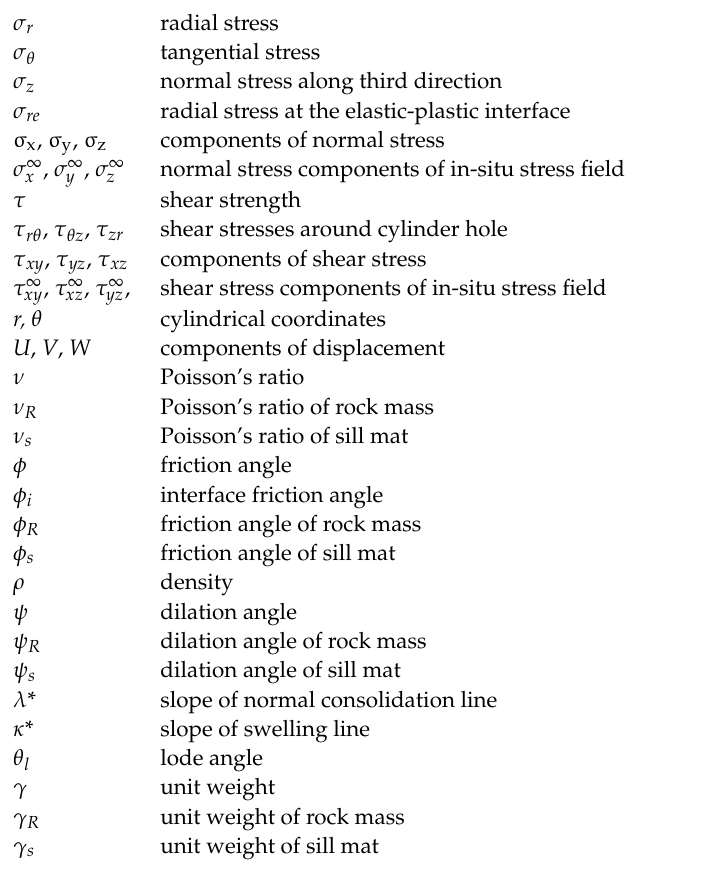
Figure A1. The origin locates at the central point of the model. In the figure, a is the radius of the hole. Domain size is the distance from the hole to the model boundary. r and θ are the cylindrical coordinates. The model is characterized by Young’s modulus E and Poisson’s ratio ν .